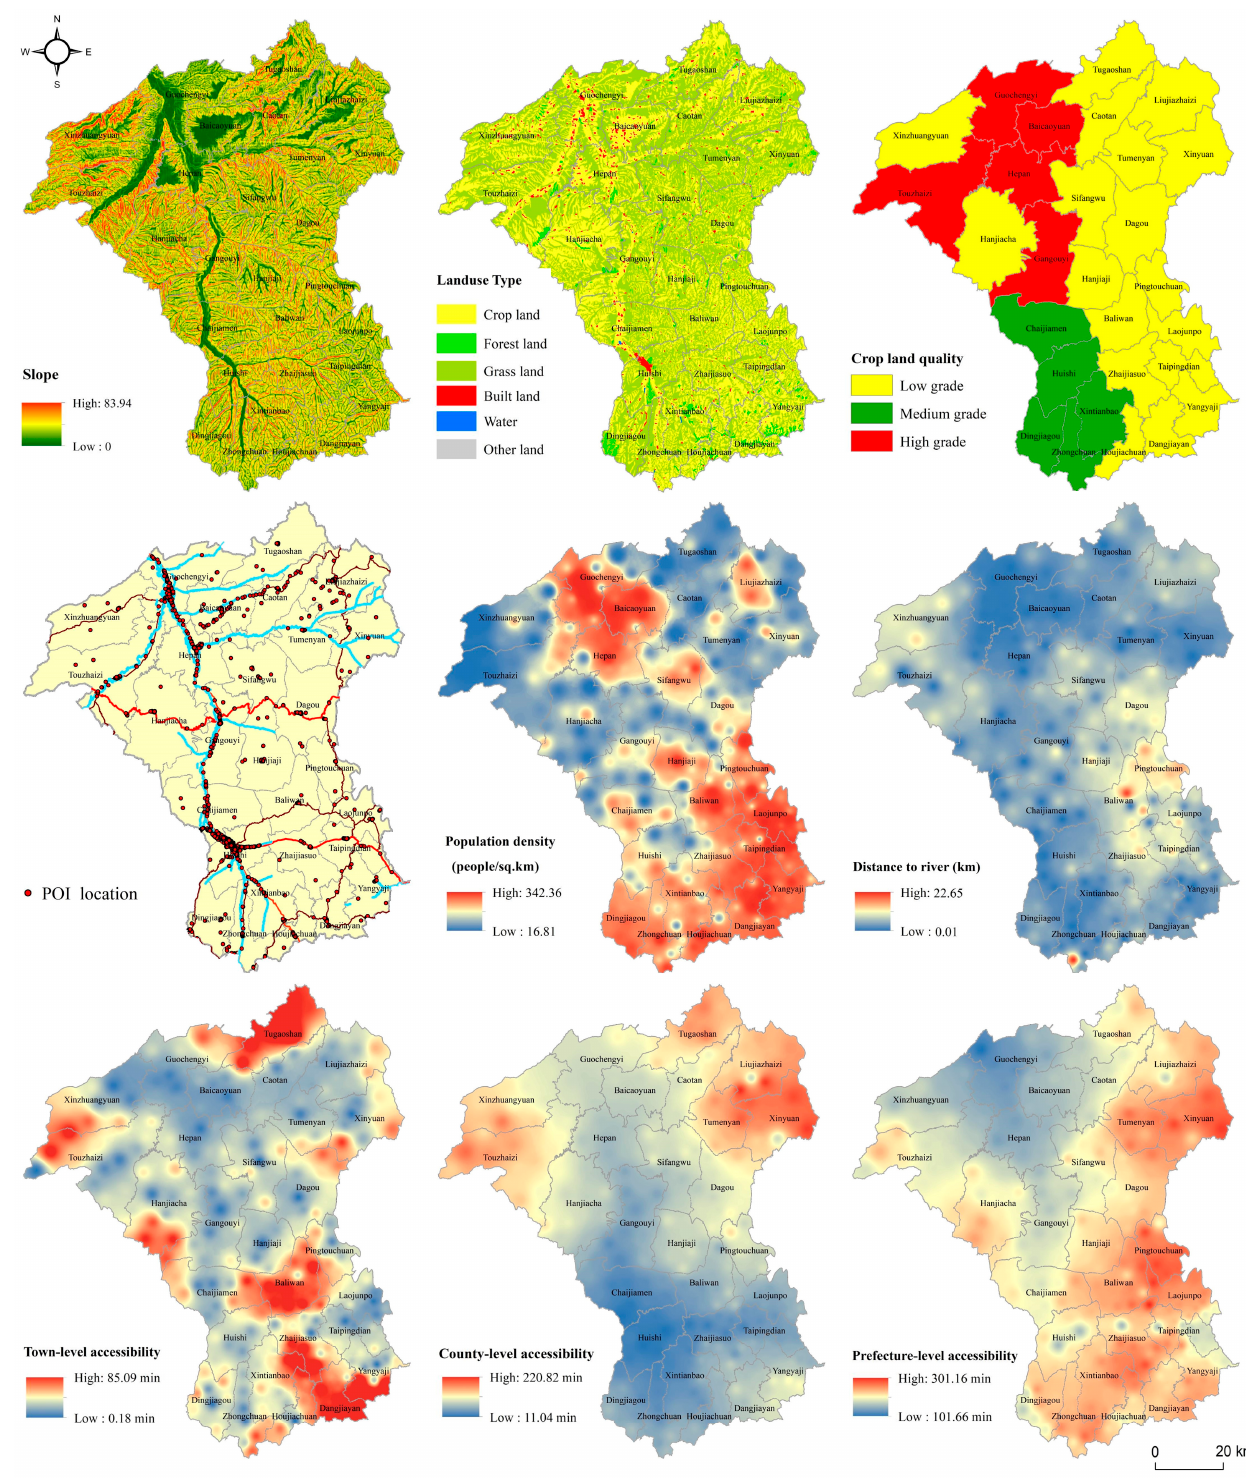
Figure 2. Spatial distribution of explanatory variables.